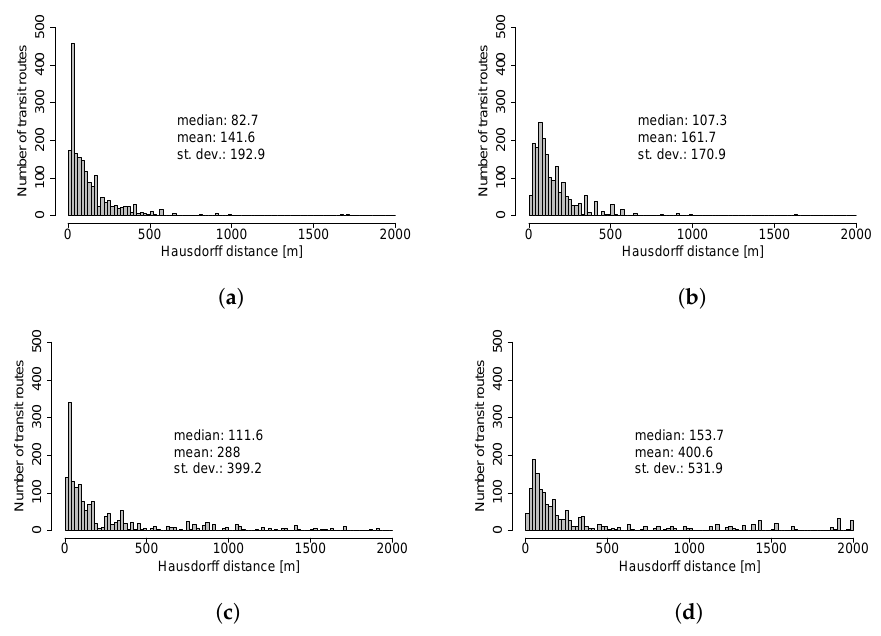
Figure 8. Histogram for Hausdorff distances between the mapped transit routes and GTFS shapes. ( a ) pseudo routing with stop locations; ( b ) pseudo routing with parent stops; ( c ) implementation